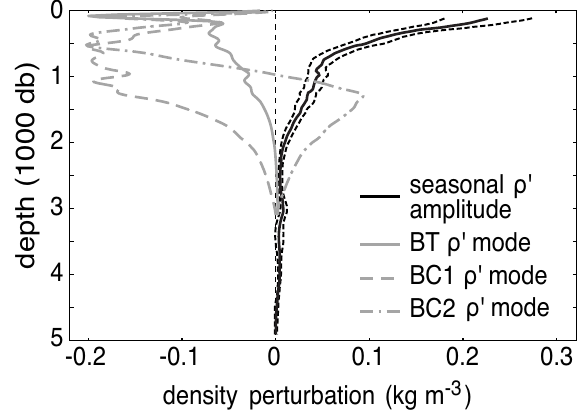
Fig. 9. Vertical modes and seasonal density anomalies at EBH. The profile of peak to peak seasonal density perturbation (solid black), with standard deviations (dotted black) and as calculated for the full EBH profile that extends out to EB1 at a water depth of H = 5050. Flat-bottomed density modes are shown for the barotropic (BT, solid gray), the first baroclinic (BC1, dashed gray), and second baroclinic modes (BC2, dash-dotted gray) calculated at EBH for which H = 3000m (see text). All modes are normalized to have a minimum amplitude of –0.2 for visualization purposes and are of arbitrary